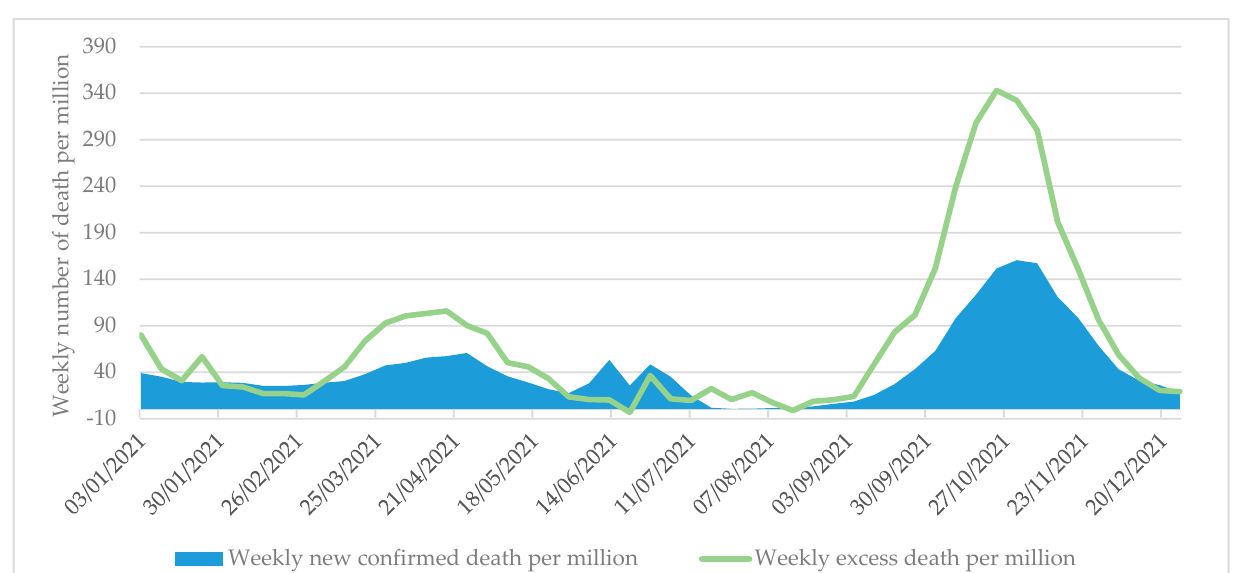
Figure 3. Weekly number of confirmed COVID-19 death per million and weekly excess death per million in Romania between 27 December 2020 and 26 December 2021. Sources: University of Oxford [21].